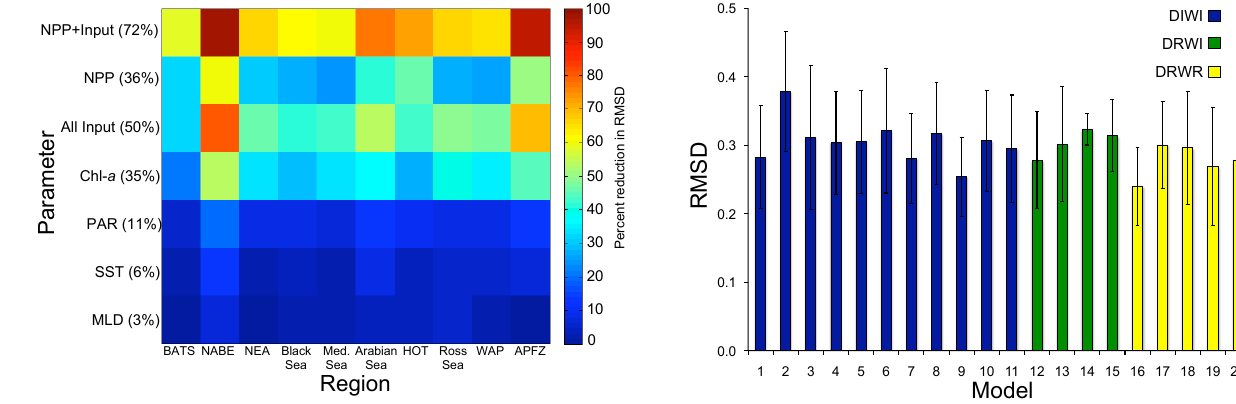
Fig. 6. Average RMSD for each model across all regions. Error bars are 2 × standard